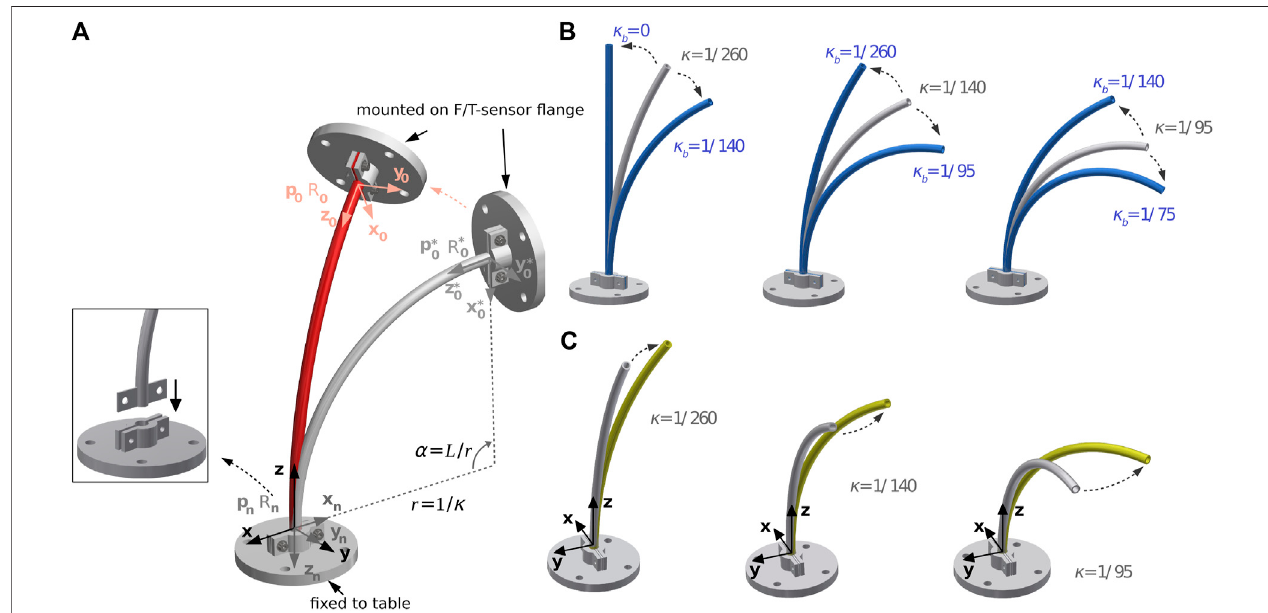
FIGURE 3 | Overview of the bending and torsion test for three single pre-curved tube: (A) general setup, (B) positional changes for bending, and (C) positional changes for torsion.